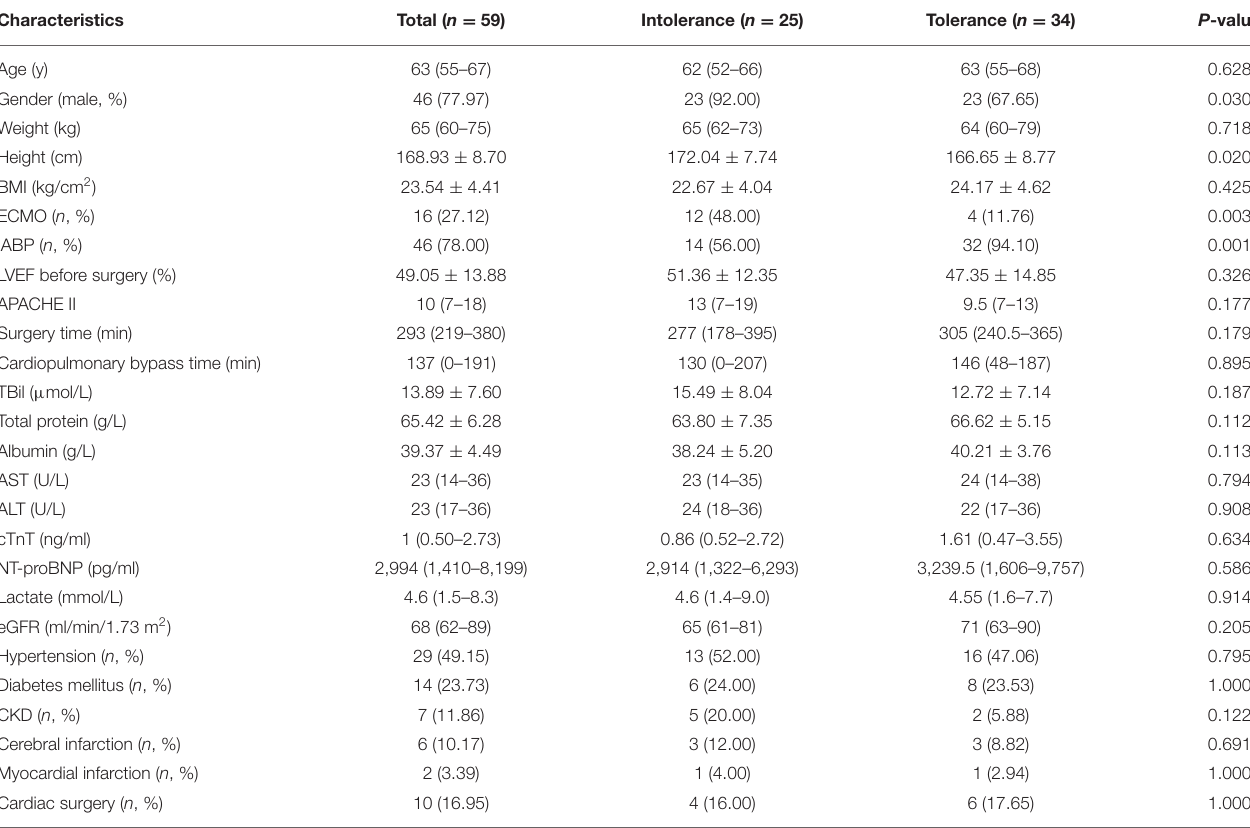
TABLE 1 | Patient baseline characteristics grouped by EN intolerance or